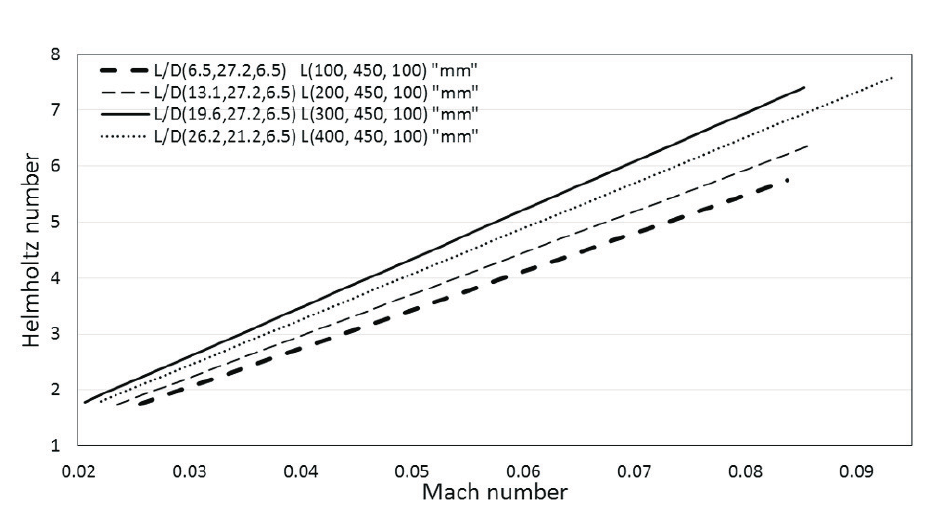
Figure 22. Helmholtz number He plotted against Mach number M for L up = 100–400 mm, L corr = 450 mm, and L dw = 100 mm. Table 18. Mach number and corresponding Helmholtz number ( He ) range for pipe systems in Case